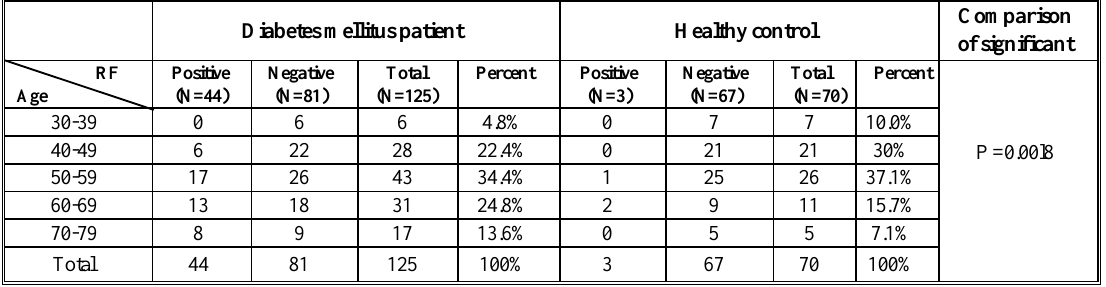
Table 3: Distribution of diabetic patients who have RF positive and negative within age groups (years) compared with healthy control.